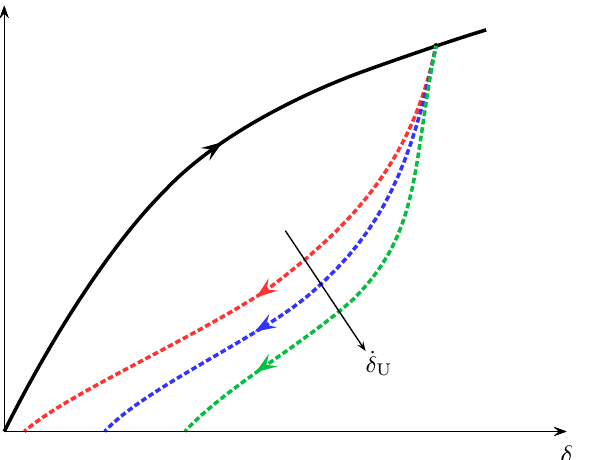
Figure 3. The schematic of the load-displacement curve of a non ideal rubber-like material. The inelastic effects are demonstrated by the irreversibility of the loading-unloading behaviour for different unloading rates ˙ δ U .